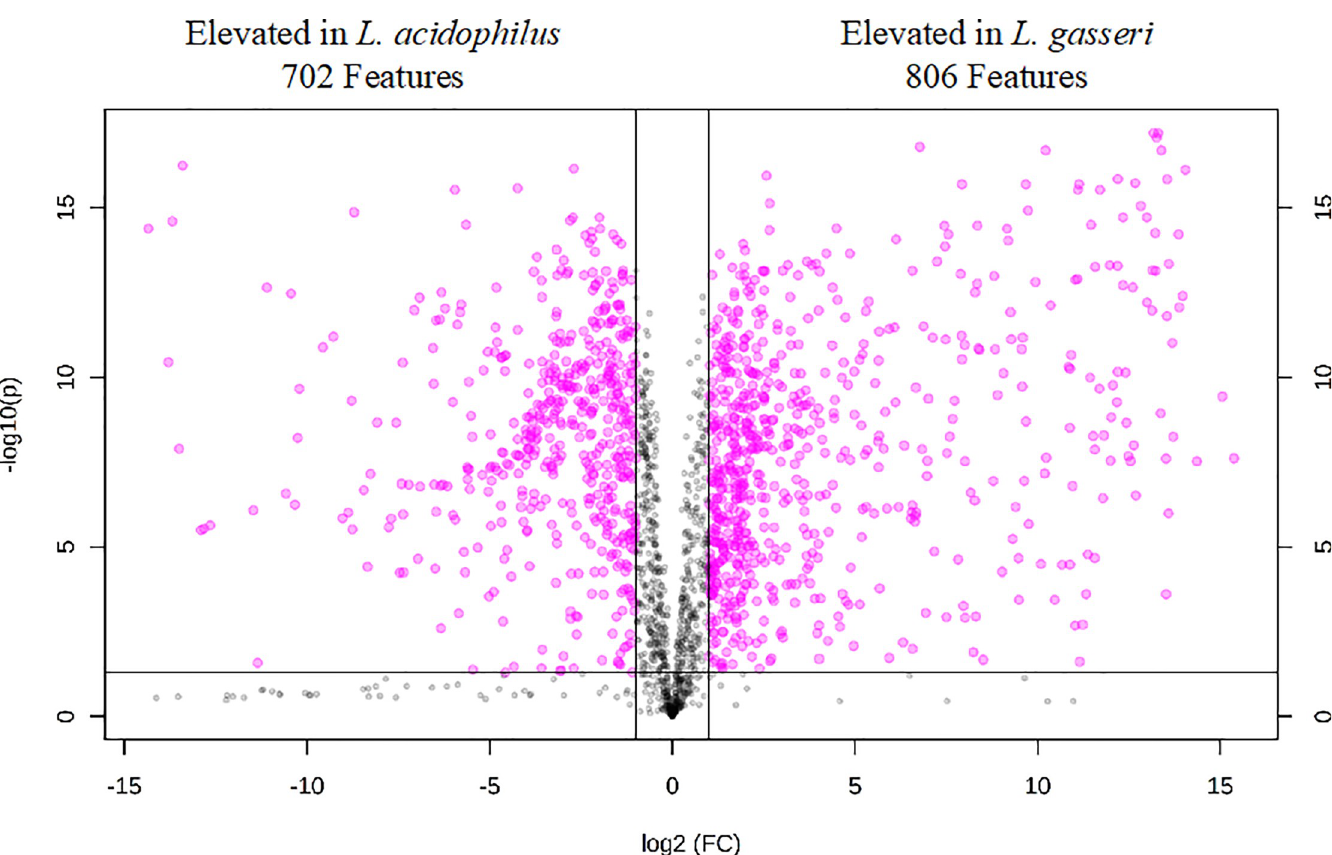
Fig 1. Volcano plot depicting high metabolomic diversity between L . acidophilus and L . gasseri . A total of 1508 features (72.6%) showing a statistically significant difference in their relative intensities between species with 702 (46.6%) showing elevated expression in L . acidophilus and 806 (53.4%) showing elevated expression in L . gasseri